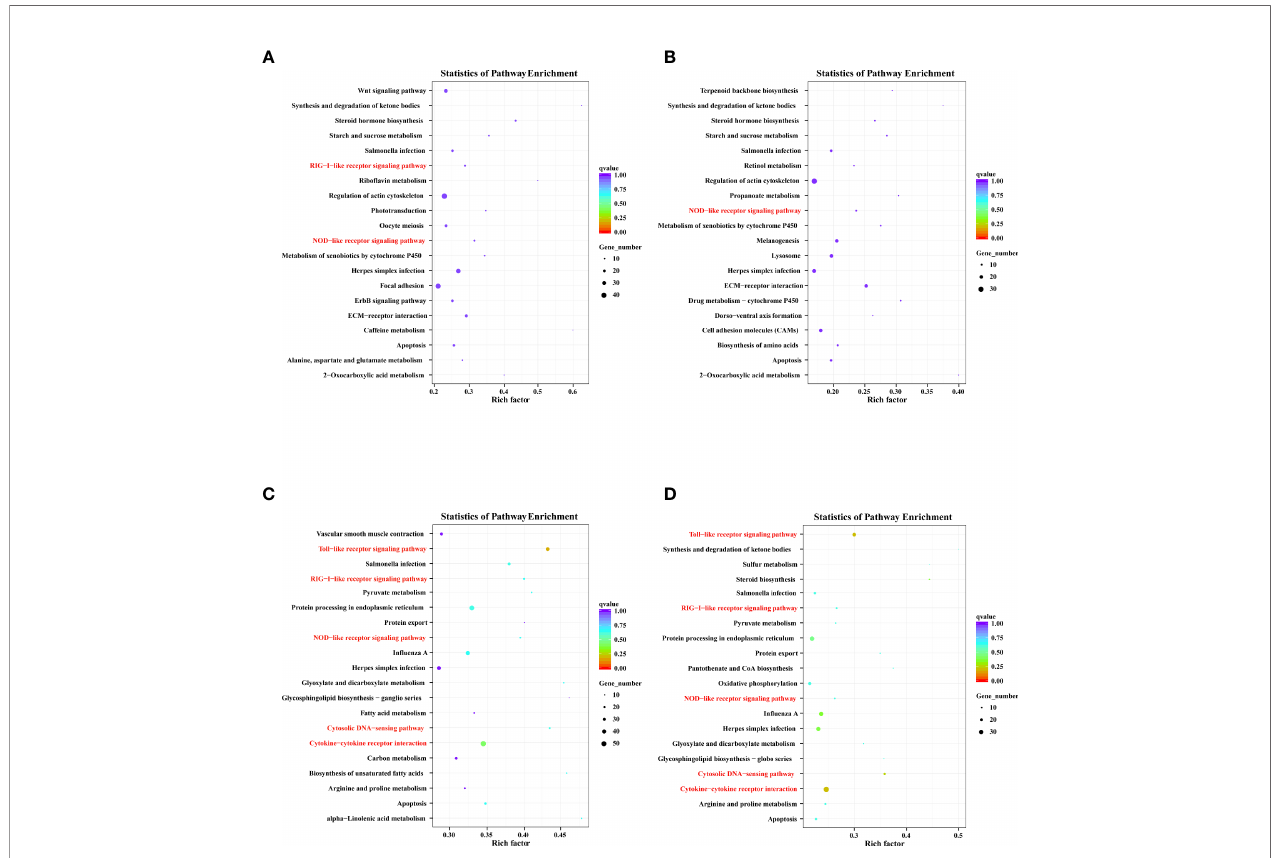
FIGURE 6 | Top 20 KEGG pathway terms based on DELs ’ cis-target genes of D-vs-N group (A) , DELs ’ cis-target genes of H-vs-N group (B) , DELs ’ trans-target genes of D-vs-N group (C) , and DELs ’ trans-target genes of H-vs-N group (D)